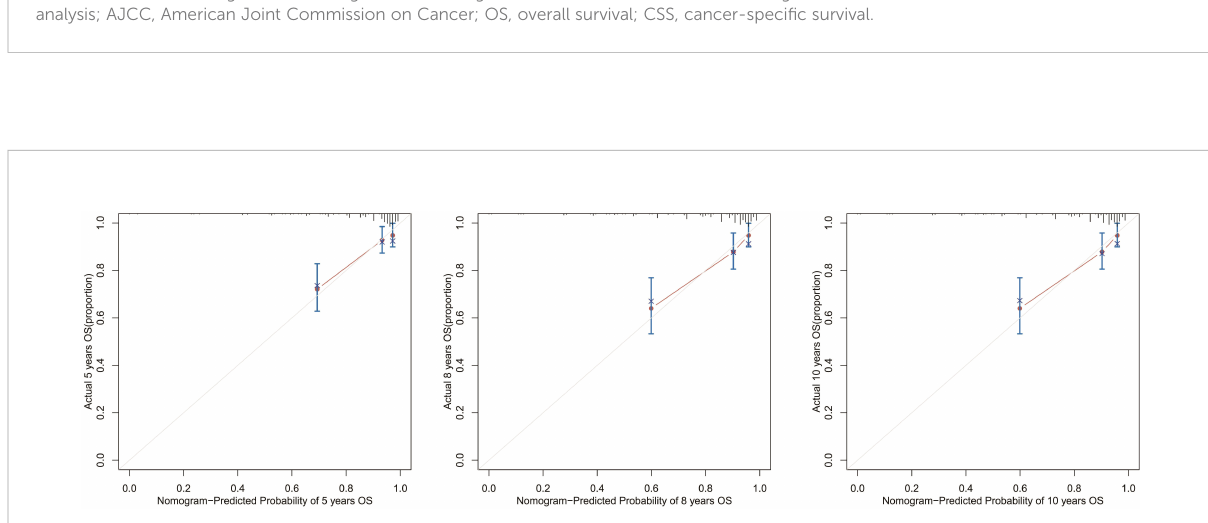
FIGURE 11 Calibration curves for the OS nomogram. 5-, 8-, and 10-year calibration curves for the OS nomogram in the external validation